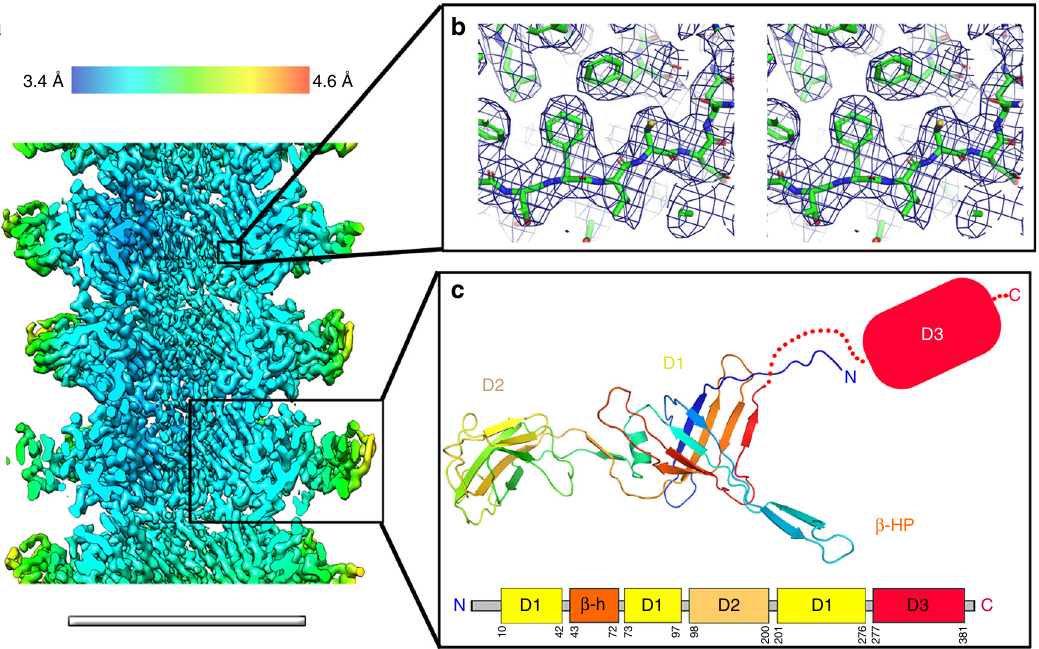
Fig. 5 Cryo-EM structure of the YSD1 tail. a Surface representation of the cryo-EM helical reconstruction of the tail tube. The colour gradient represents the local resolution of the map. Scale bar = 10 nm. b Stereo diagram showing the electron density map and de novo model of the tail protein. c The tail tube protein YSD1_22 is composed of three structural domains and an extended β -hairpin loop ( β -HP). Domains 1 and 2 were modelled in the cryo-EM density, while only weak density was present for domain 3 (D1-3; cf. Supplementary Fig.